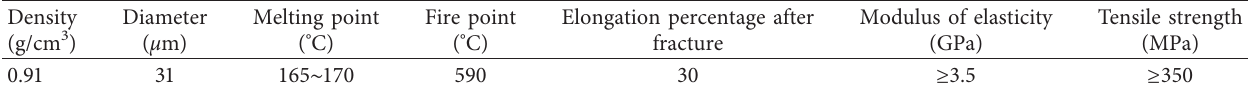
Table 1: The properties of